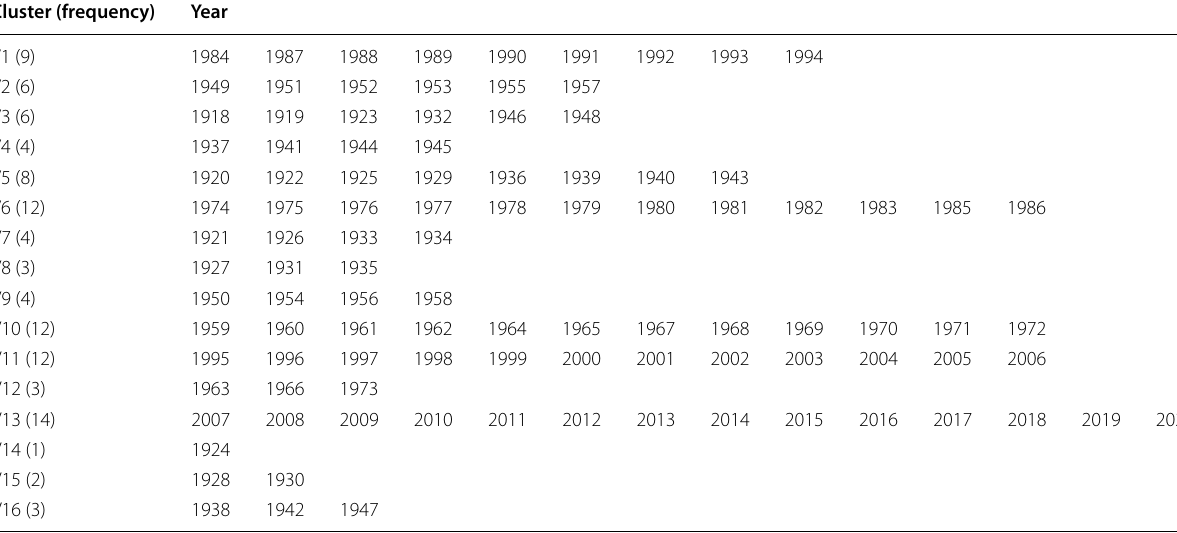
Table 1 Clustered data frequency (in parentheses) and years in SOM grids Cluster